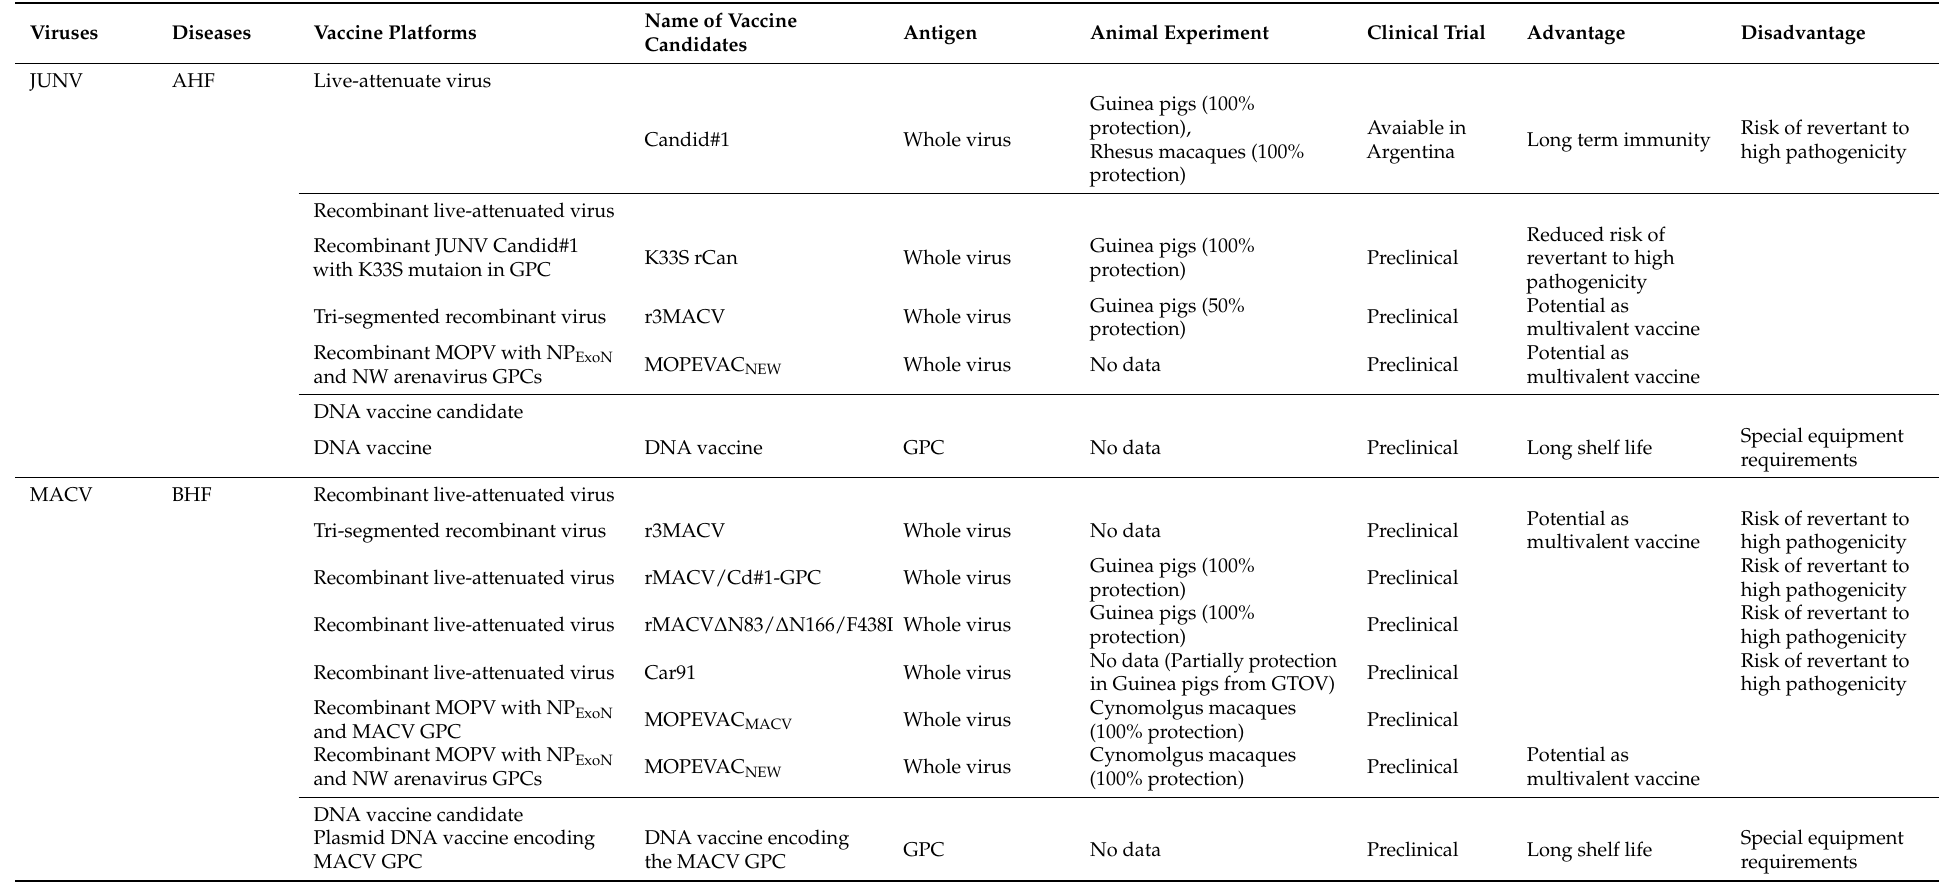
Table 2. Summary of vaccine candidates for NW arenavirus